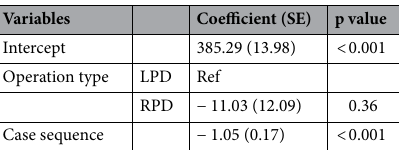
Table 3. Multivariable regression for operation time in operation type and case sequence.